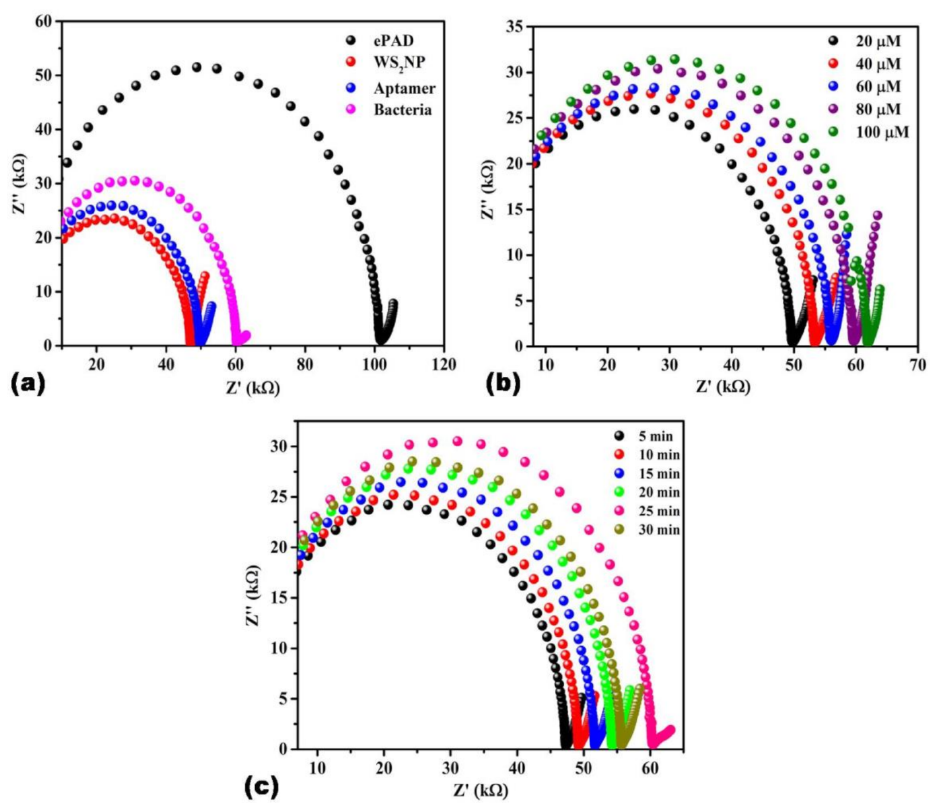
Figure 2. ( a ) Nyquist plot of a range of electrochemical paper analytical devices (ePADs) consists of ePAD, WS 2 NS/ePAD, aptamer/WS 2 NS/ePAD, and bacteria/aptamer/WS 2 NS/ePAD; ( b ) Nyquist plot of aptamer/WS 2 NS/ePAD at different concentrations of probe aptamer ranging from 20 µ M to 100 µ M; ( c ) Nyquist plot at different incubation times in 0.1 M KCl containing 0.1 mM methylene blue (frequency range of 100 Hz–10